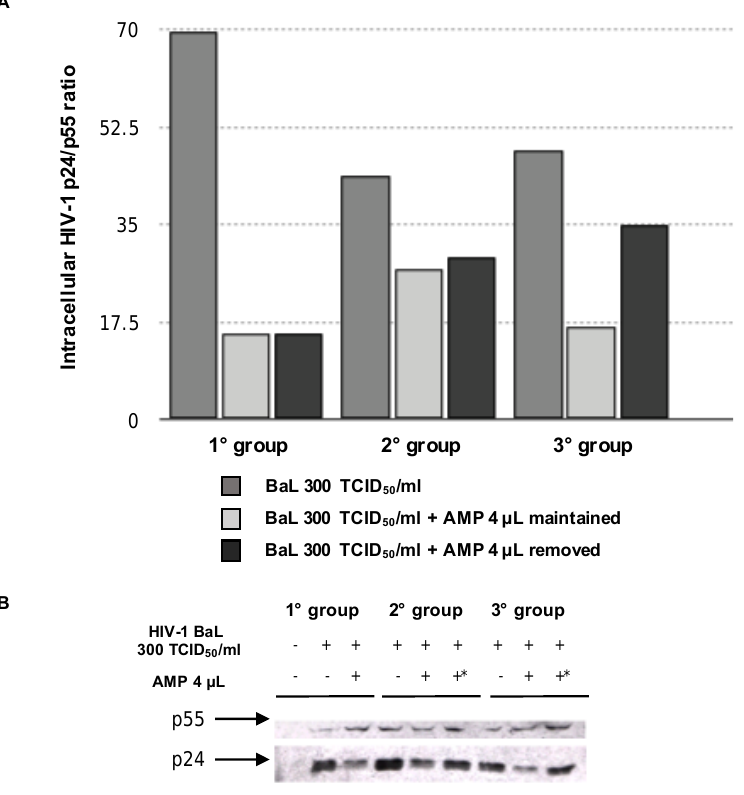
Figure 5. ( A ) Effects of AMP removal on p24 maturation in HIV-1 BaL chronically-infected MDM. p24 maturation was expressed as the ratio of p24 amount on p55 amount in cell lysates. p24 and p55 amounts were determined by ELISA; ( B ) western blot analysis showing p24 and p55 amount detected in cell lysates from chronically-infected macrophages. * Indicates the removal of AMP. In ( A , B ), the following experimental conditions were tested: Group 1, 18th day infection and 7th day treatment; Group 2, 18.5th day infection and 7.5th day treatment; Group 3, 19th day infection and 8th day treatment. HIV-1 BaL refers to an HIV-1 strain isolated from alveolar macrophages by a bronchoalveolar lavage.